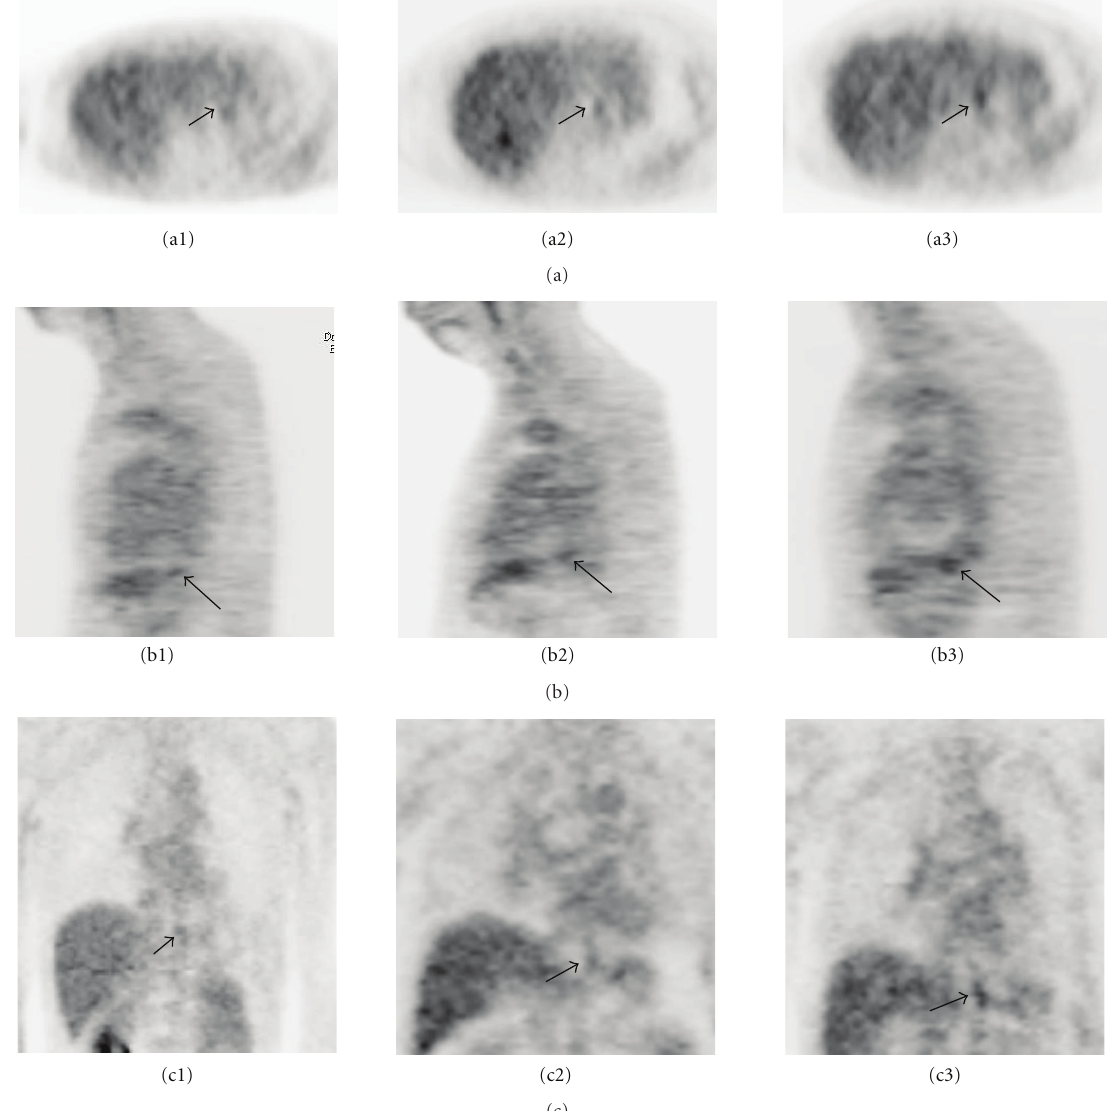
Figure 2: FDG-PET images showing increased FDG uptake in the distal esophagus (arrows) in the esophagitis group. (a) Transverse view, (b) sagittal view, and (c) coronal view. The maximum SUV of grade M (a1, b1,c1), grade A (a2, b2,c2), and grade B, and 3C (a3,b3, c3) was 2.3, 2.8, and 3.0,